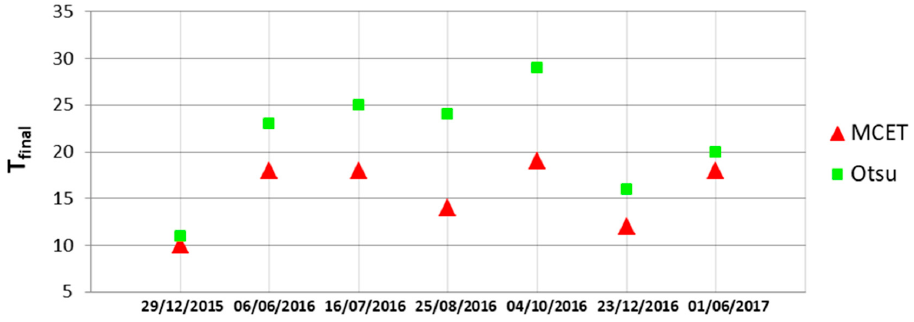
Figure 7. Estimated T final discriminating open-water subclass for 7 dates and for the cases 7.